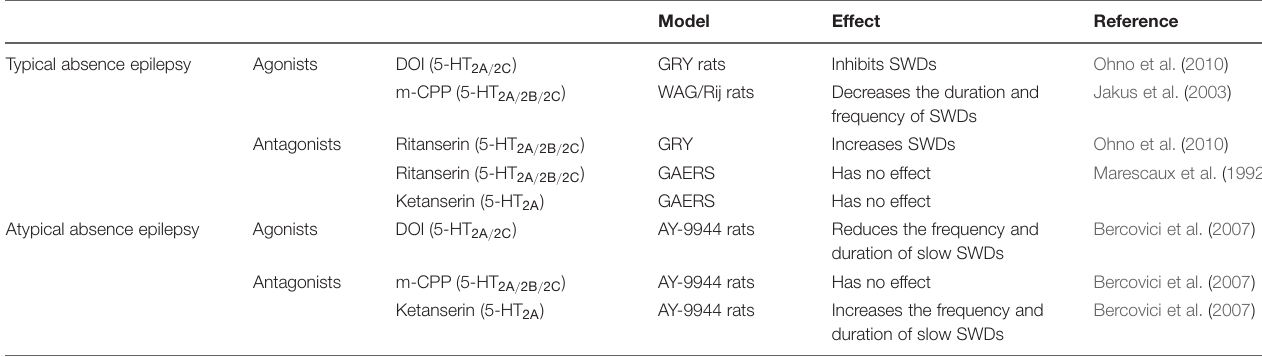
TABLE 2 | Role of the 5-HT2A receptors in absence